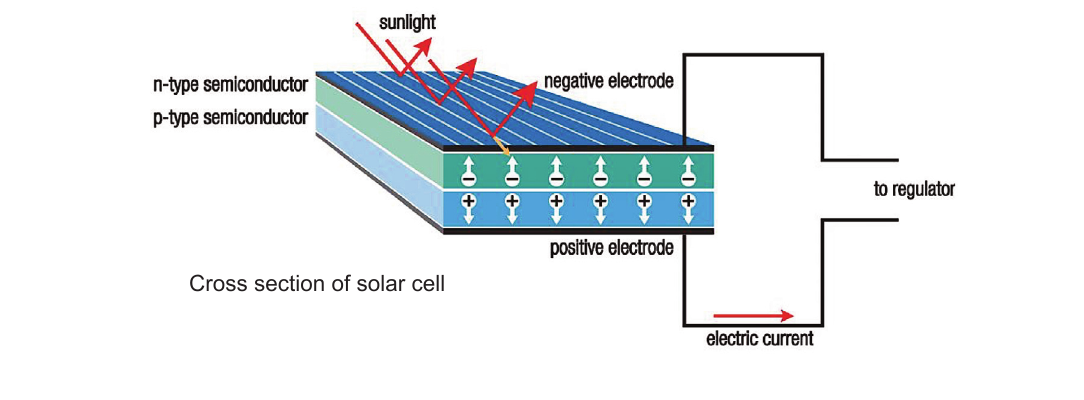
Fig. 1. Schematic cross section of c-Si solar cell [5].